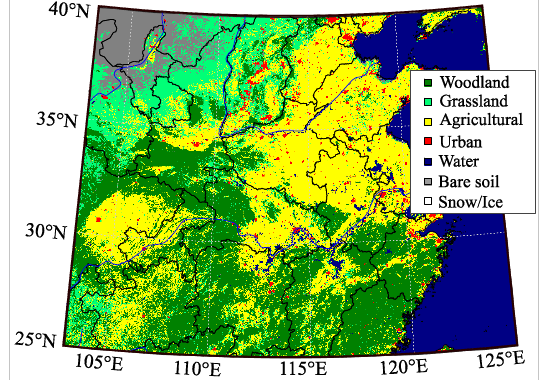
Figure 4. Landcover map of the study area (available at the National Institute for Environmental Studies, Tsukuba, Japan, http://db.cger.nies.go.jp/dataset/landuse/en/).